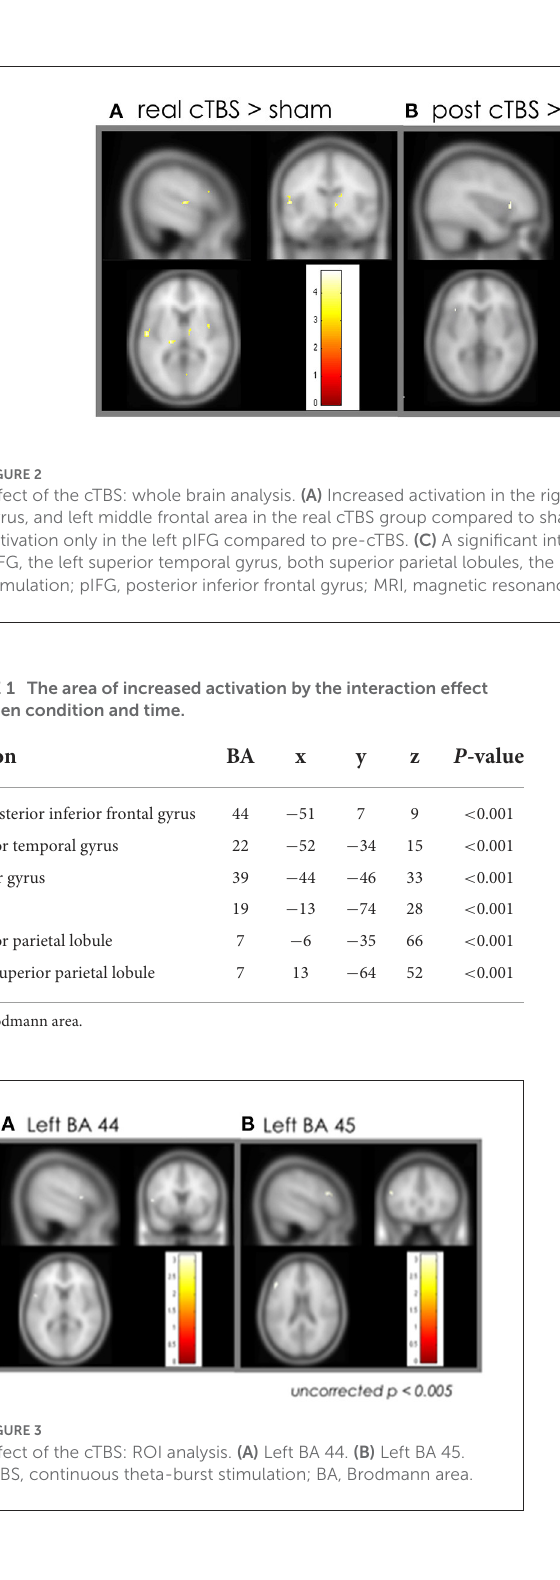
lobule, left angular gyrus, and left cuneus. These findings suggest two possible interpretations. First, offline-cTBS may have increased neuronal activity in the stimulated area (left pIFG) and in other brain regions within the language network